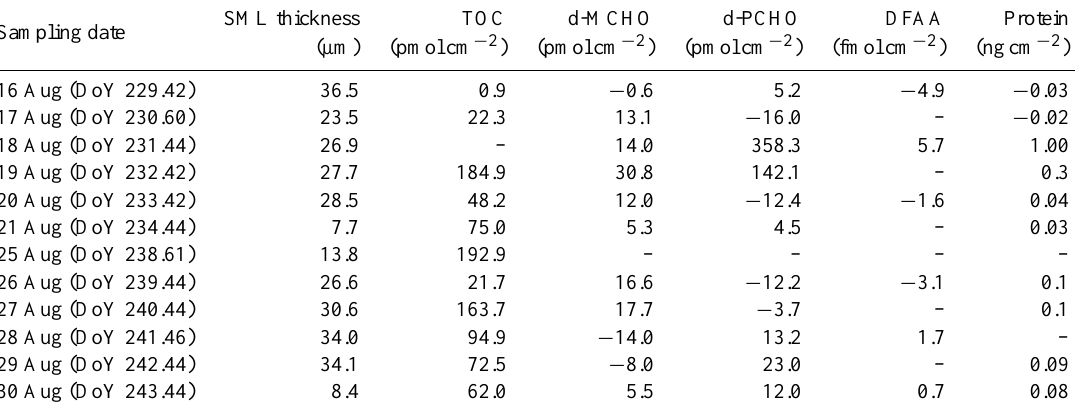
Table 4. Surface microlayer (SML) excess concentration of TOC, d-MCHO, d-PCHO, DFAA and particulate